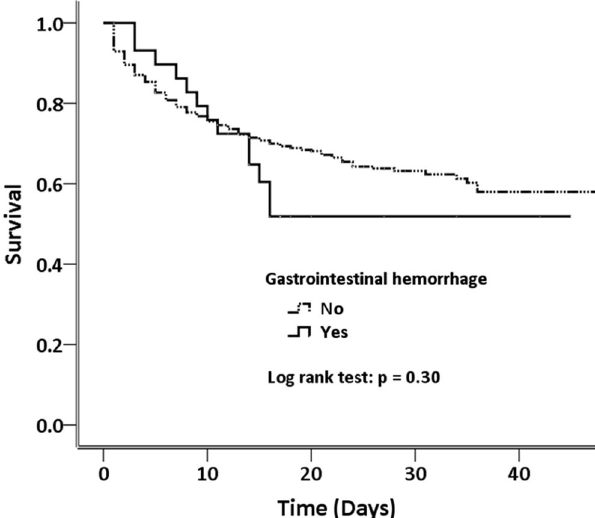
Figure 2. Kaplan–Meier survival curves for SAH patients with or without gastrointestinal